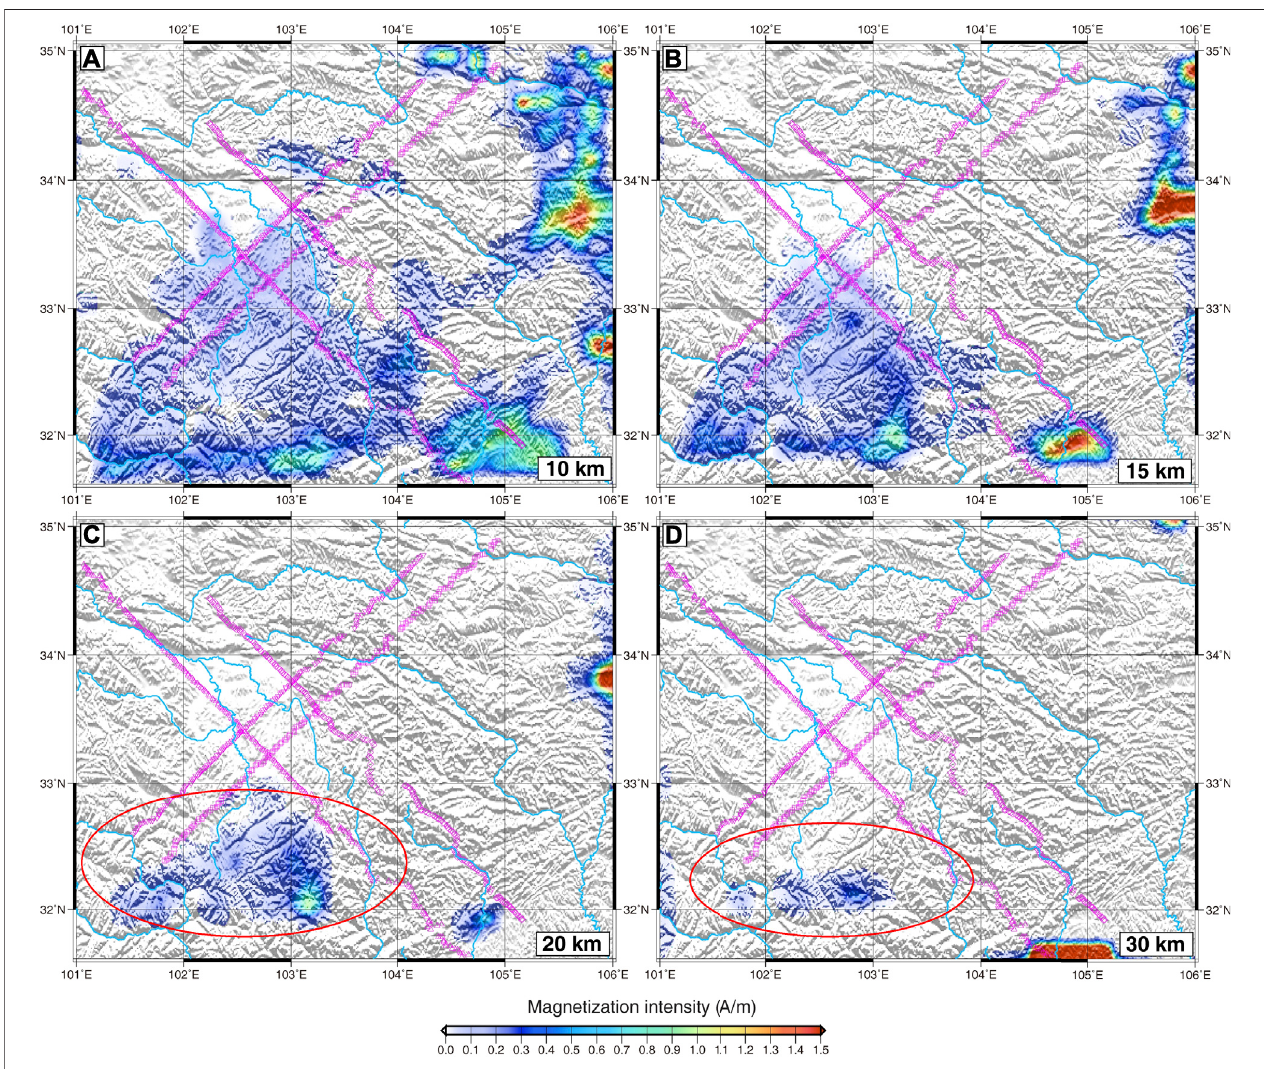
FIGURE 10 | Songpan − Aba area magnetization map: (A) 10 km (B) 15 km (C) 20 km, and (D) 30 km.